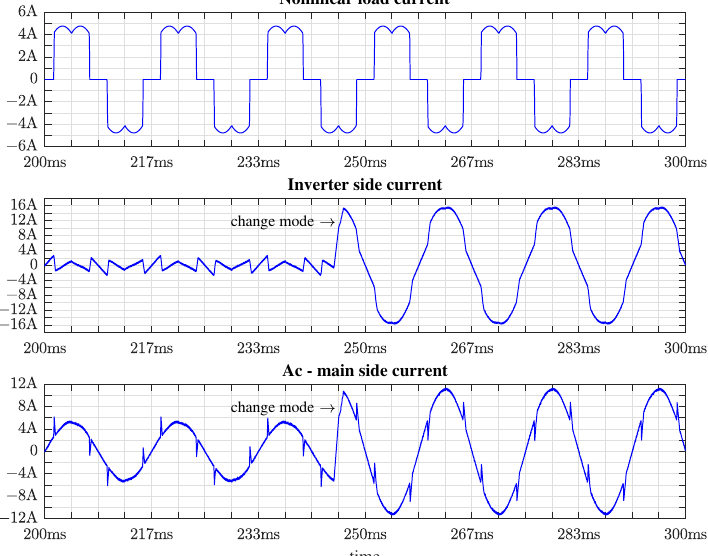
Figure 7. Main waveforms in power converter: from top to bottom, non linear load current, inverter side current (compensation current), ac-main current (compensated current).